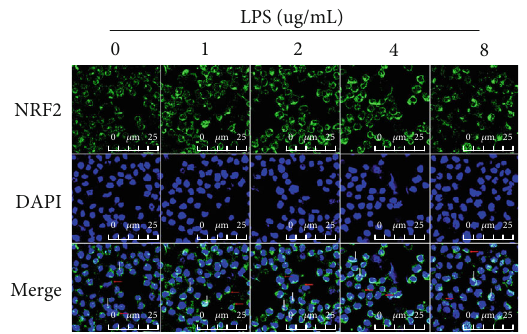
Figure 2: LPS increased nuclear abundance of NRF2 in gEECs. GEECs are exposed to di ff erent concentrations of LPS for 12 hours, and then the dynamic changes of cytoplasmic and nuclear NRF2 was imaged by immuno fl uorensent staining. Scale bar was 45 μ m. The red arrow indicates NRF2 located in the cytoplasm, and the white arrow indicates NRF2 located in the